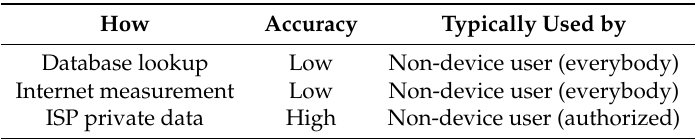
Table 1. Overview of device-independent location based on IP